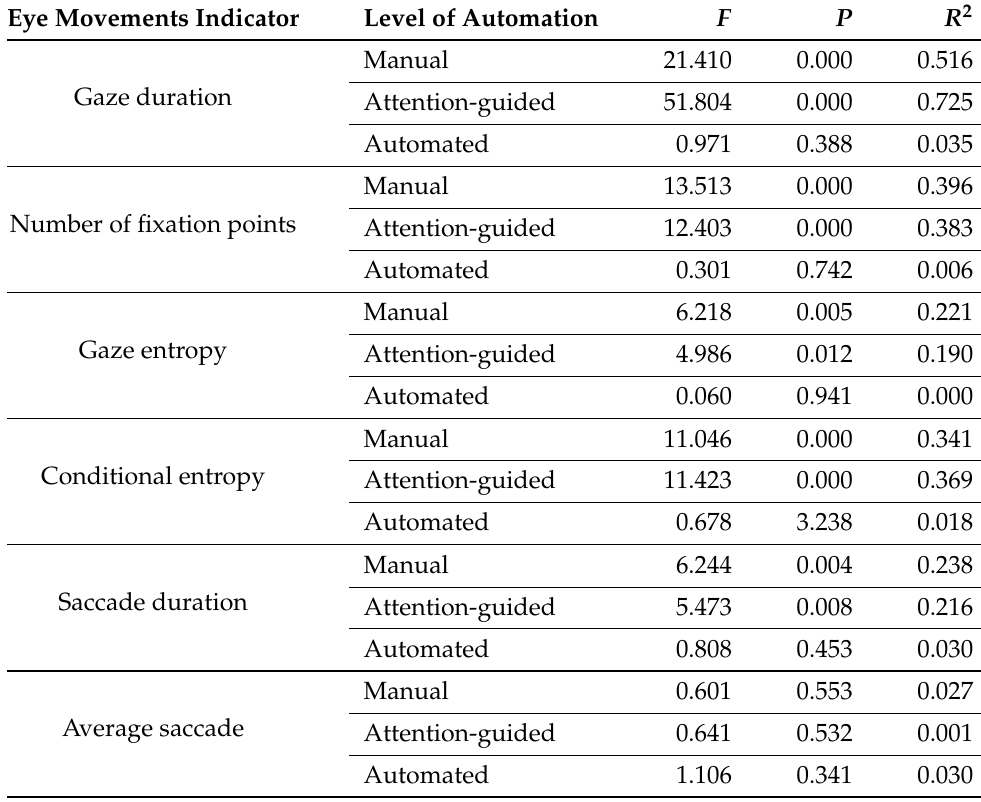
Table 7. Statistical tests on the effects of traffic on eye movements.